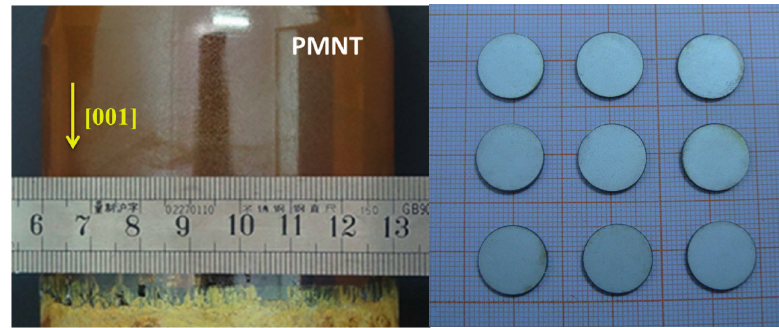
Figure 1. Photograph of the 3-inch PMN-30PT single crystal and ϕ 14 mm wafers.